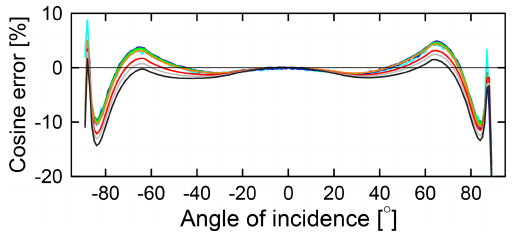
Figure 4. Cosine error of the GUVis-3511 radiometer in one az- imuthal plane at wavelengths between 395 and 1020nm. Color cod- ing is identical to that of Fig. 8. Measurements performed at the orthogonal plane are similar. Measurements at wavelengths below 395nm are affected by noise and are not shown for clarity. (A figure with cosine errors in the UV is provided in the